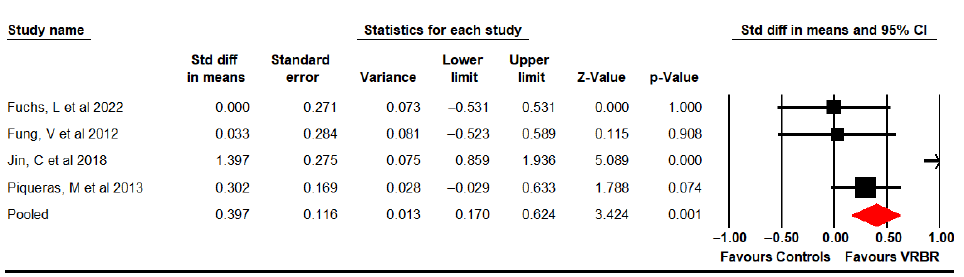
Figure 5. Forest plot of the immediate effect of VRBR on knee flexion range of motion [63,64,66,68].